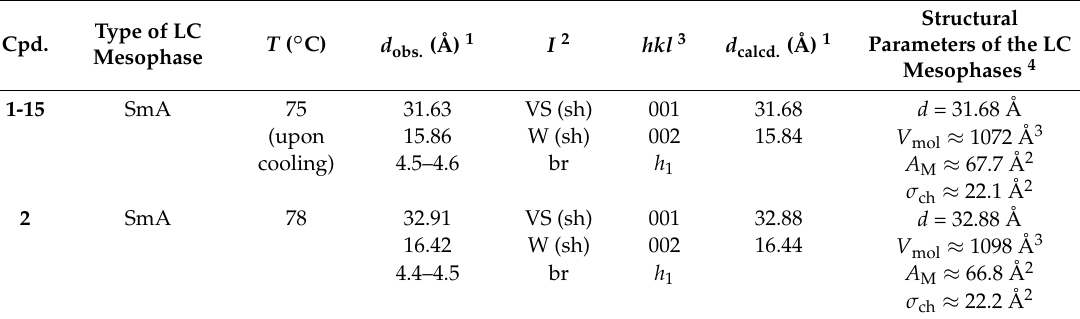
Figure 3. Synchrotron-based SWAXS data that were recorded for the SmA phase of 1-15 at 75 °C upon cooling (the X-ray wavelength used was 1.00 Å). Table 2. Summary of synchrotron-based SWAXS data recorded for the LC mesophases adopted by 1-15 and 2 , including calculated structural parameters and corresponding assignments.